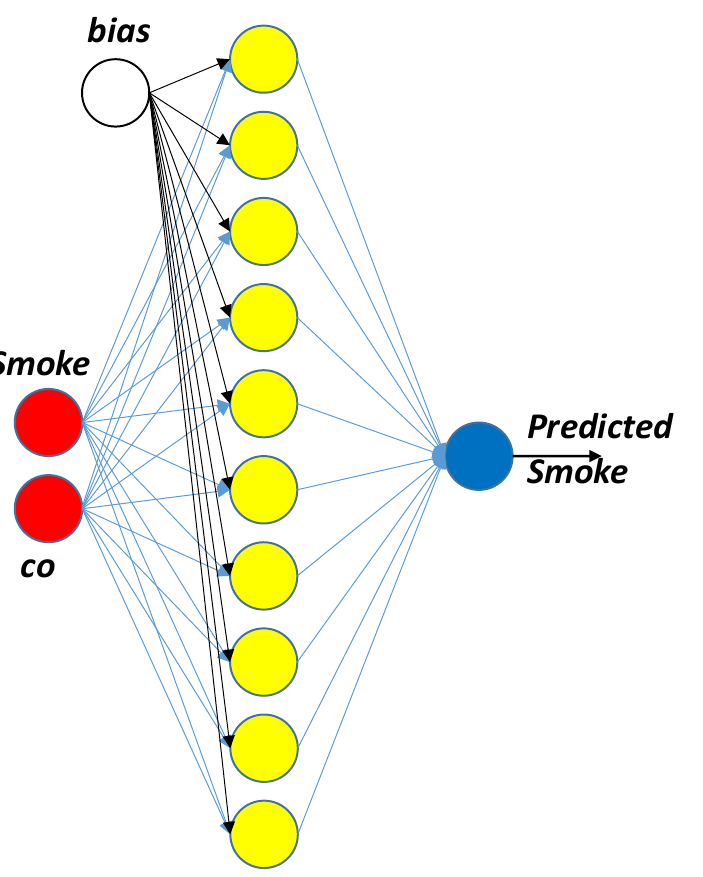
Figure A4. ANN-MLP network adopted for the prediction of the smoke variable.